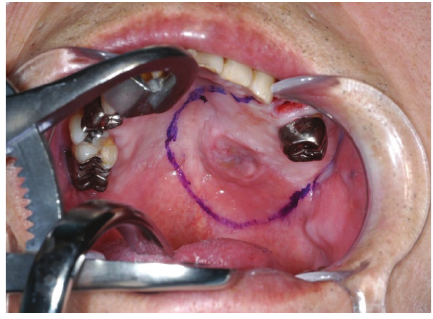
Figure 9: Intraoperative findings. Figure 10: After resection of the